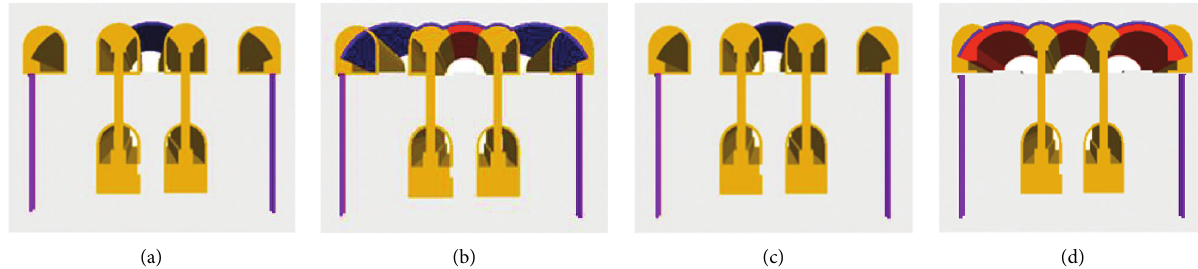
Figure 12: The construction process of arches. (a) Stage 5-1. (b) Stage 5-2. (c) Stage 5-3. (d) Stage 5-4.